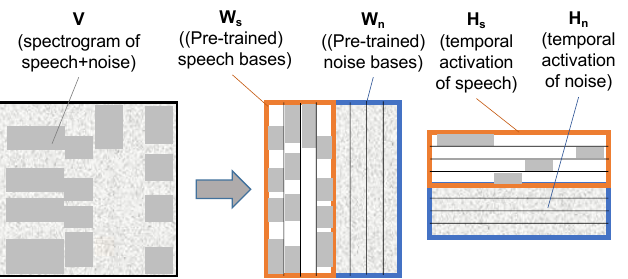
Figure 2. Schematic diagram of the applications of the non-negative matrix factorization (NMF) methods to the acoustic signal processing